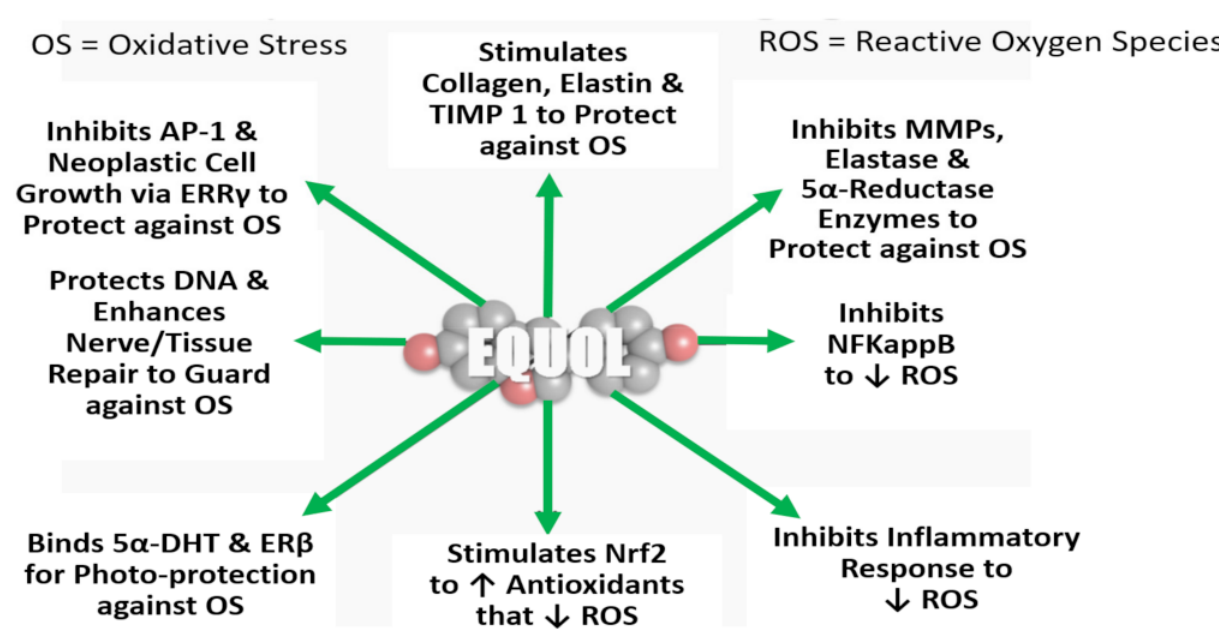
Figure 9. In vitro: how equol works as an anti-aging skin molecule. Symbols/Abbreviations: see Figure 8 legend, plus, TIMP 1 = Tissue Inhibitor of Matrix Metalloproteinase 1, inhibits the action of MMP 1; Elastase = enzyme that breaks down elastin; 5 α -reductase enzyme = the steroid enzyme that converts testosterone to the more potent androgen, 5 α -dihydrotestosterone (5 α -DHT) that inhibits dermal health 5 α -DHT = 5 α -dihydrotestosterone, the more potent androgen that has negative impacts on skin health [8,32,33]; ER β = estrogen receptor beta, that is abundant in human keratinocytes and fibroblast which phytoestrogens can bind; estrogen-related receptor (ERR) gamma ( γ